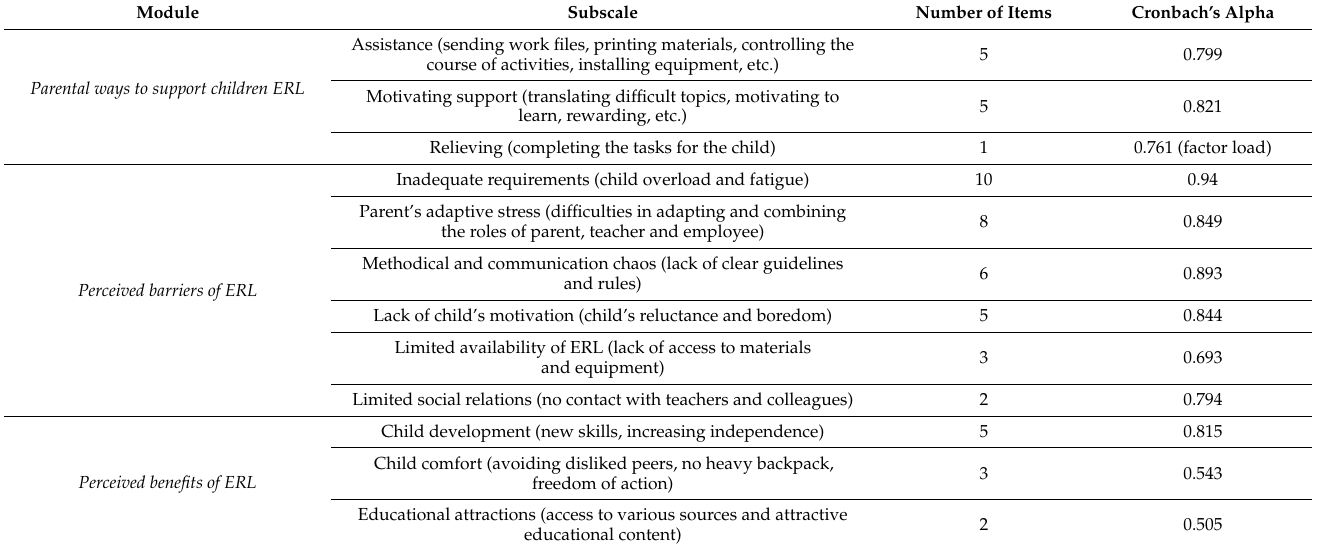
Table 1. The subscales of the